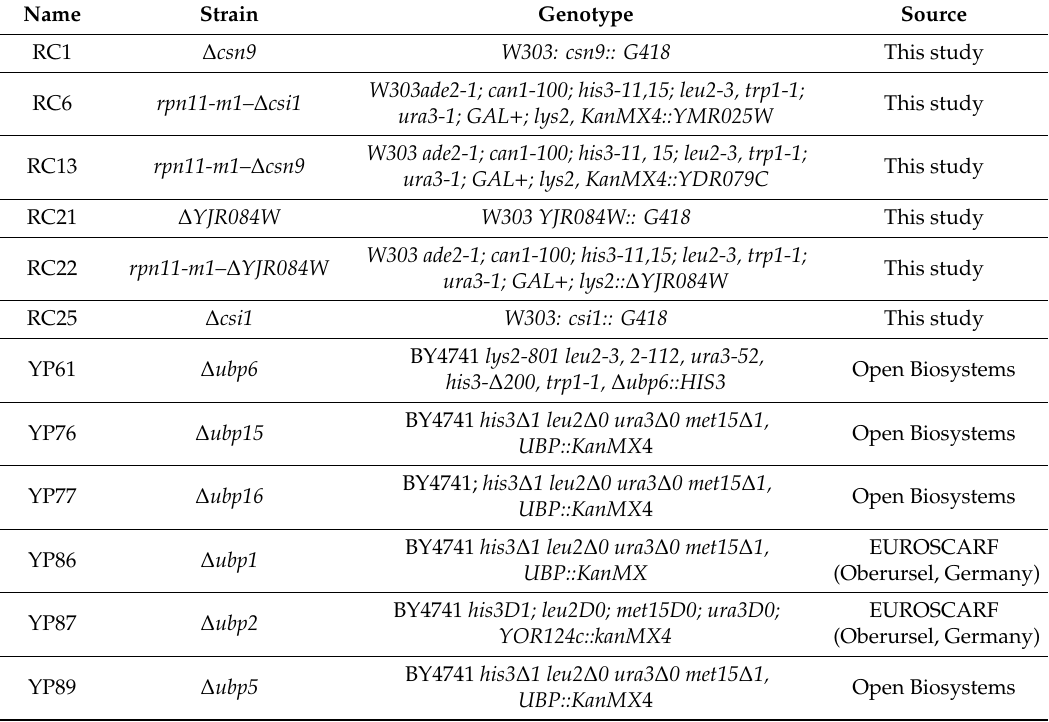
Table 2. Saccharomyces cerevisiae strains used in this